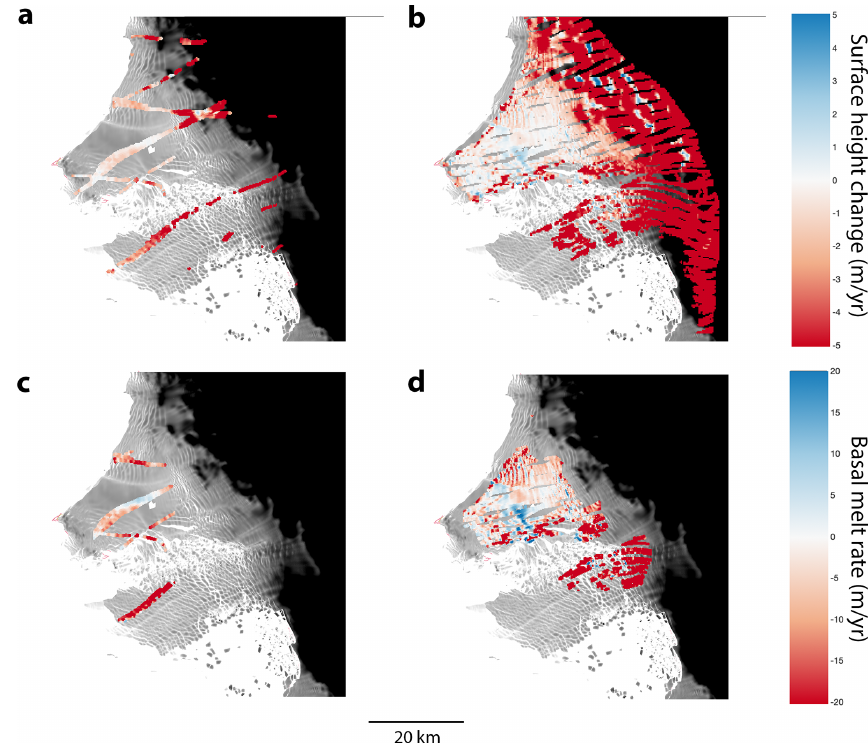
Figure 7. Lagrangian surface lowering and basal melt rates. The first row shows surface lowering between ICESat and REMA (a) and between REMA and ICESat-2 (b) . The second row shows basal melt rates between ICESat and REMA (c) and between REMA and ICESat- 2 (d) . Surface-height change and basal melt rates are interpolated to a standard 500m grid using inverse distance